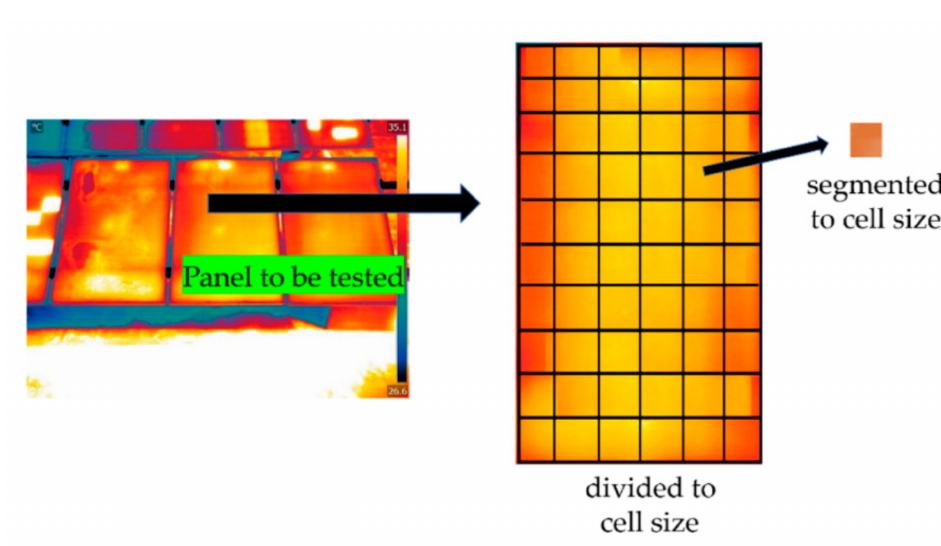
Figure 4. Experimental set-up.